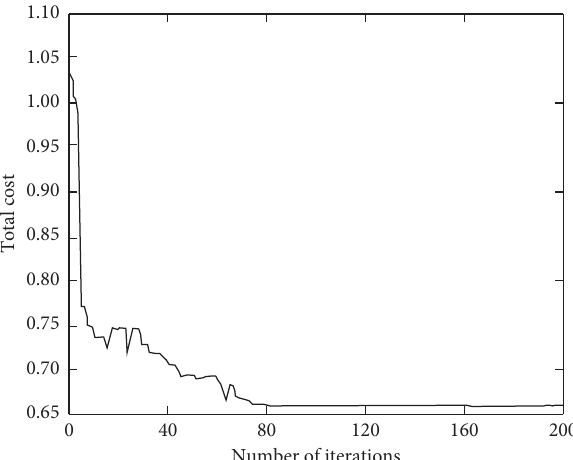
Figure 5: Effect of the number of genetic iterations on the algo- rithm performance.